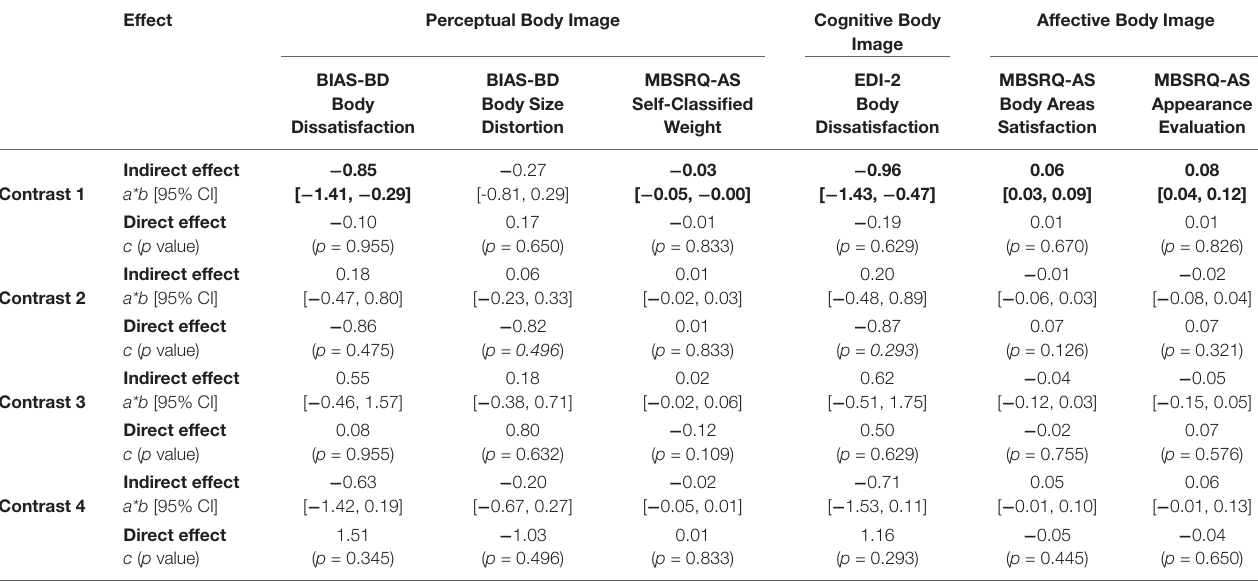
TABLE 3 | Indirect and direct effects of mediation analysis for the factors contrast as exogenous variable (contrast 1: exercise versus non-exercise; contrast 2: yoga and ballroom dance versus team and individual sports; contrast 3: yoga versus ballroom dance; contrast 4: team versus individual sports), body image variables and physical efficacy as